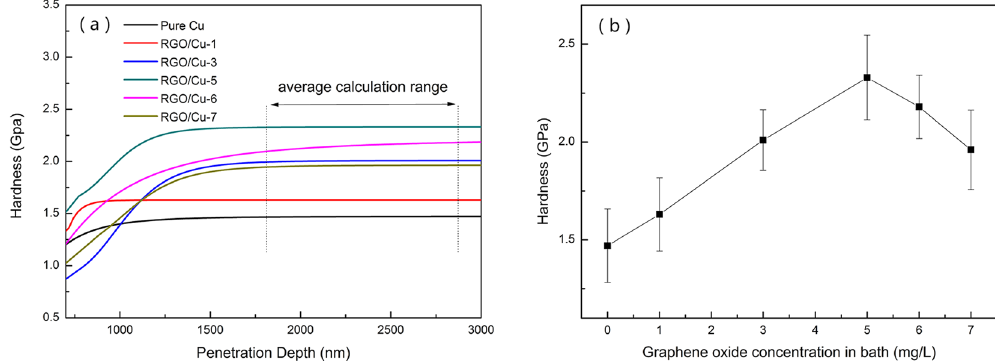
Figure 5. ( a ) Hardness as a function of the penetration depth obtained by CSM method for RGO/Cu composites which containing 0–7 mg/L GO in the electrolyte. The fitting curve was superimposed on this graph and five indentation data for each sample were used in statistical calculations. ( b ) Curve of ultimate hardness of RGO/Cu